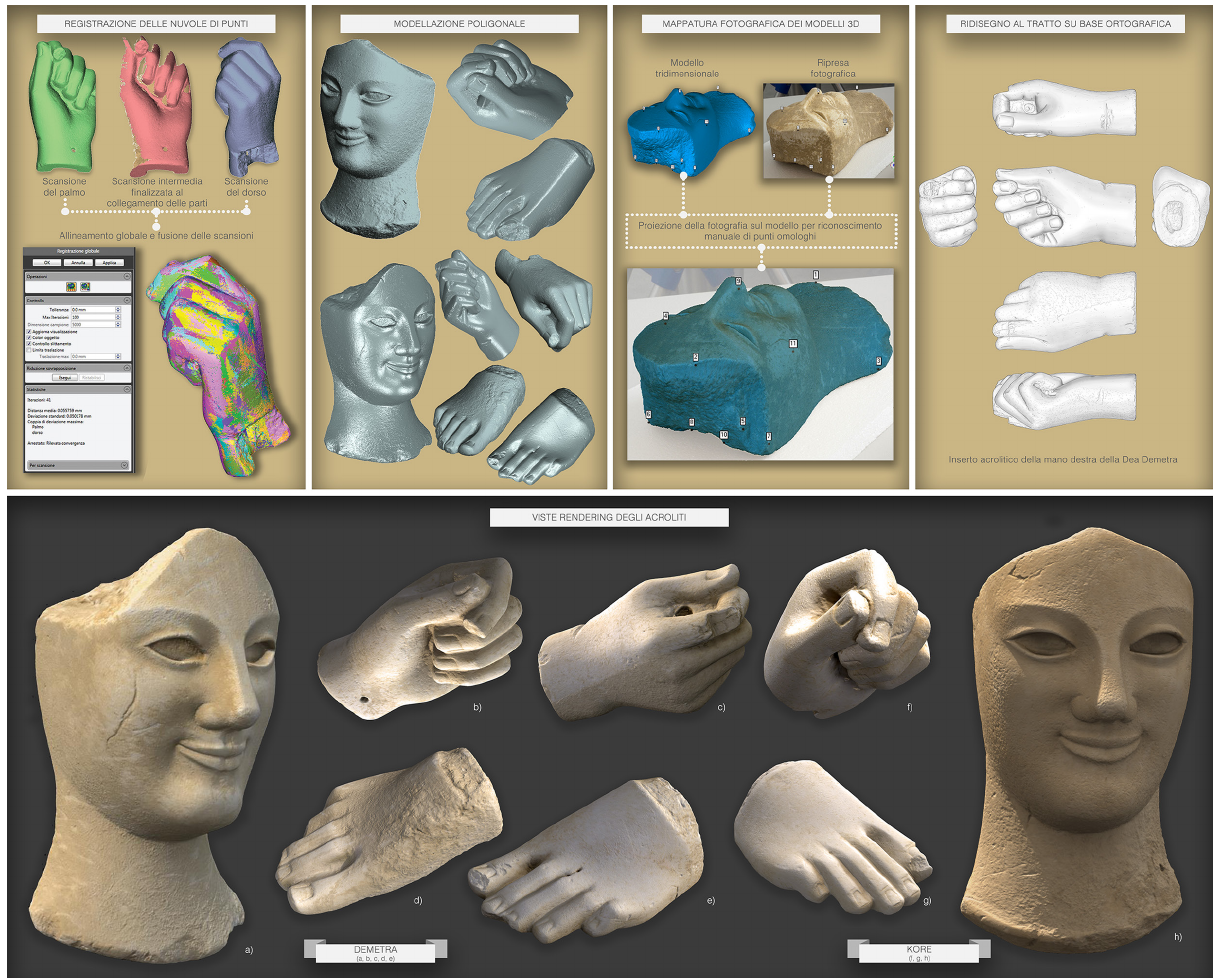
Figure 5. 3D models of Morgantina’s Acroliths: acquisition procedure by handheld 3D scanner technology and